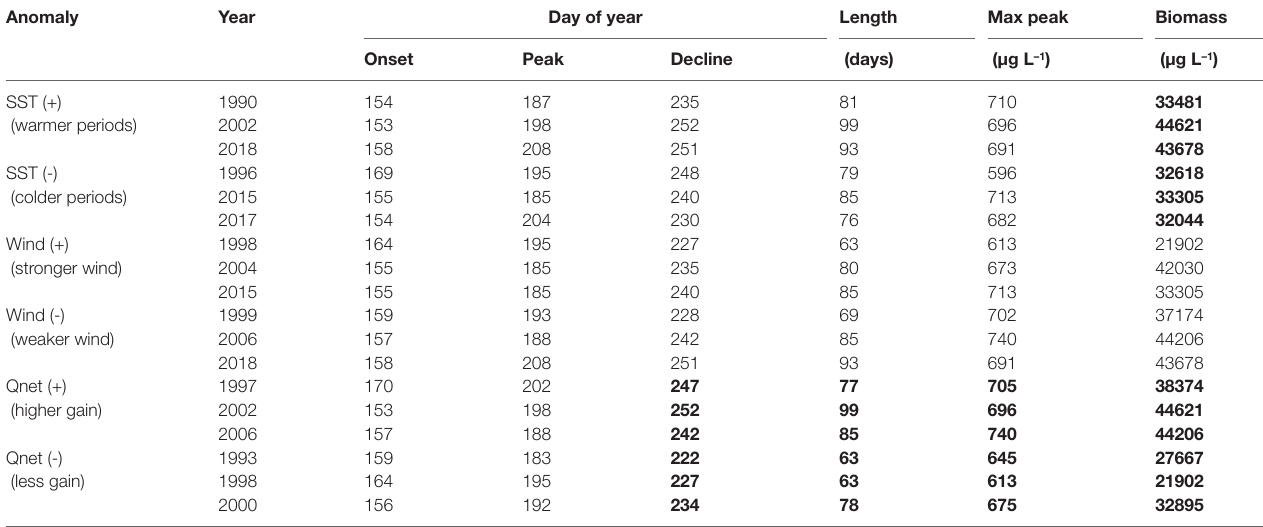
TABLE 5 | Cyanobacteria biomass integrated over the bloom period (June-August) calculated for the periods with the highest (+) and smallest (-) anomalies in SST, wind and net heat flux (Qnet).